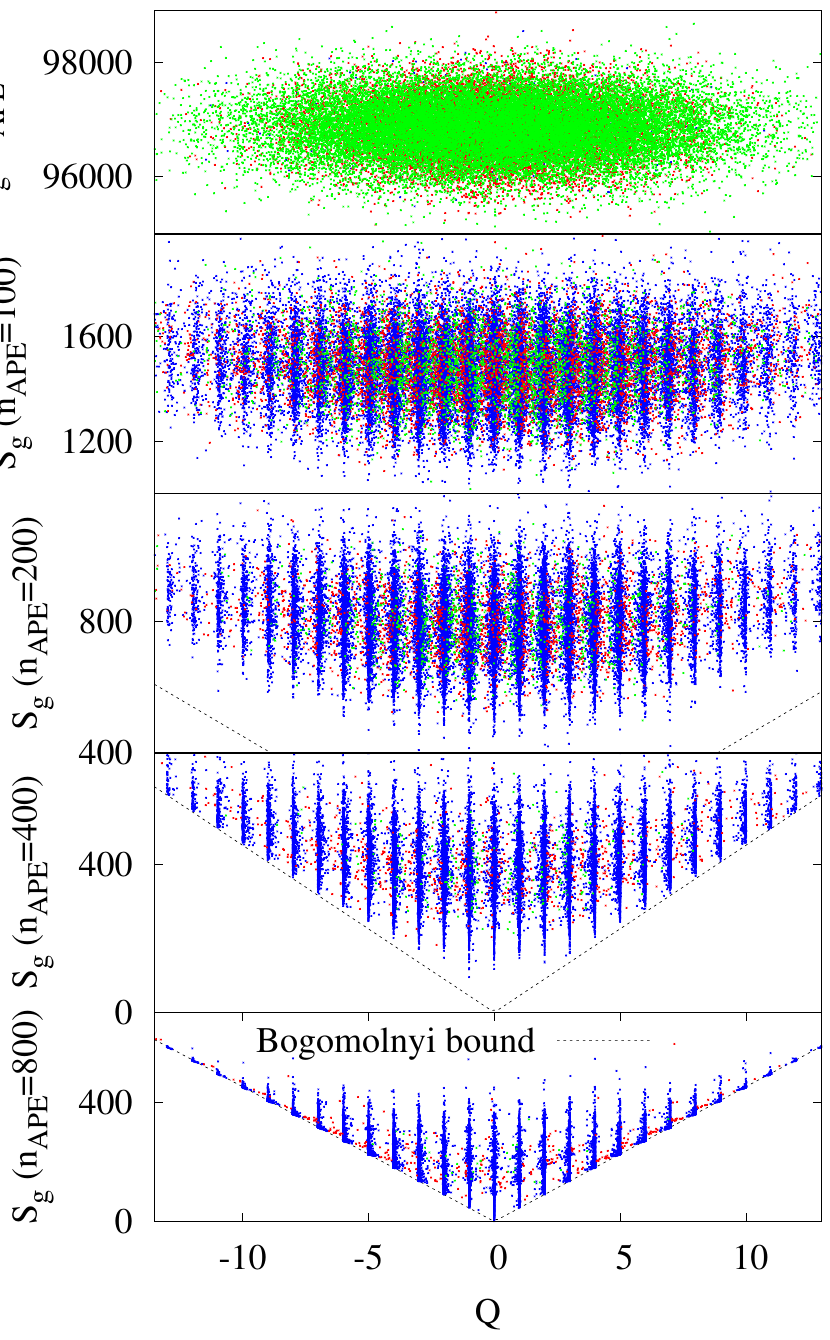
Figure 2 . Correlation between the topological charge Q and the action S g at smearing steps n APE = 1 , 100 , 200 , 400 , 800 (from top to bottom) at β = 1 . 750 . Blue, red, and green dots represent the configurations in which | Q | are “stable”, “decreasing”, and “increasing”. The dotted lines represent the Bogomolnyi